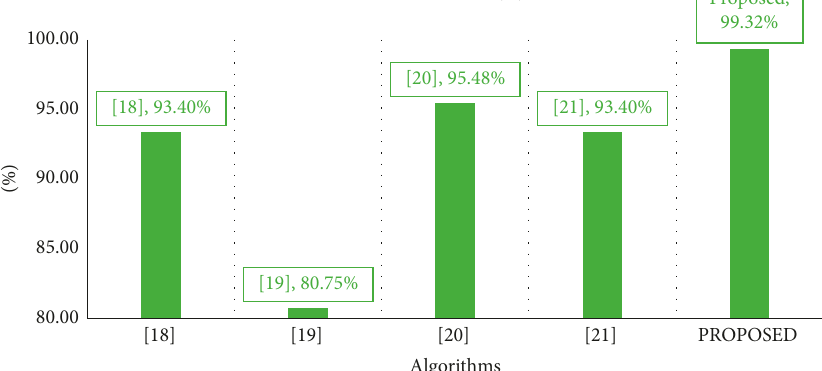
Figure 5: Comparison of accuracy